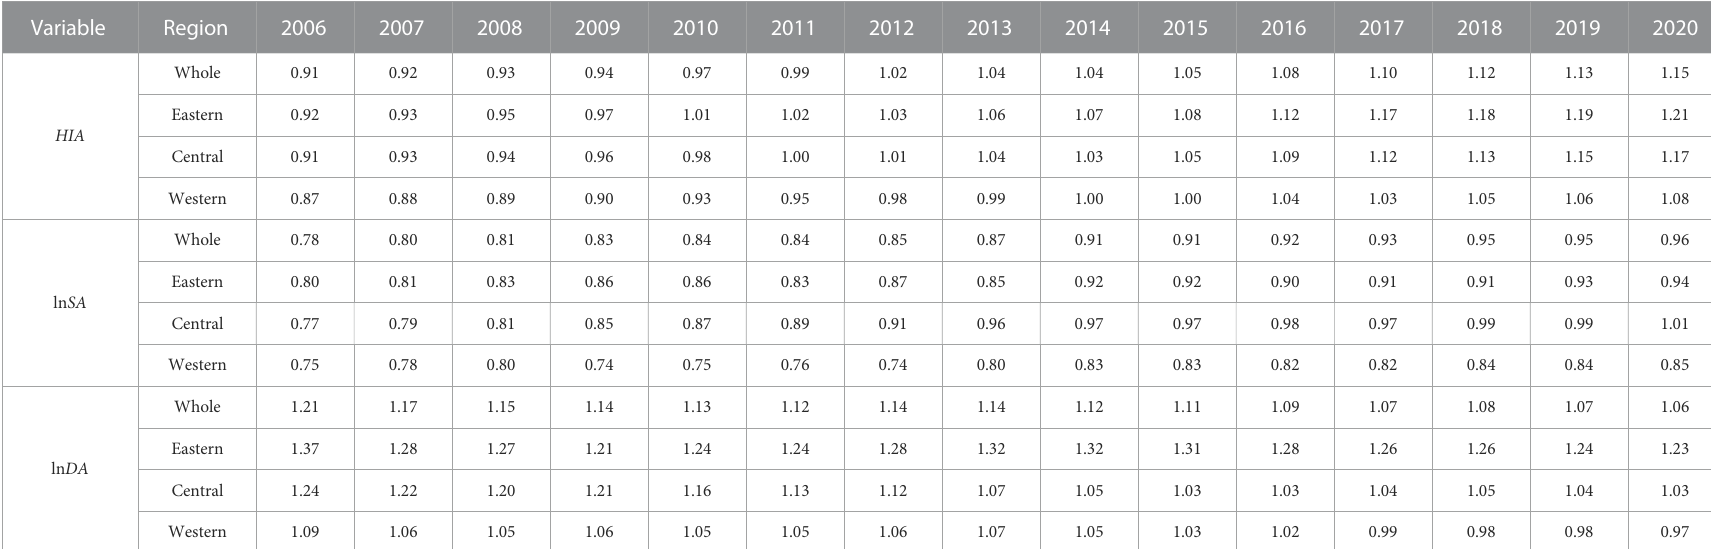
TABLE 3 The development of high-tech industrial, specialized, and diversi fi ed agglomerations.